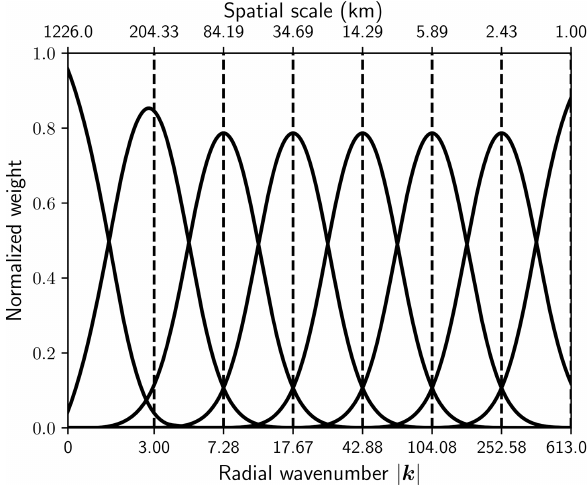
Figure 1. Normalized weight functions with corresponding Fourier wavenumbers and spatial scales for the FMI domain. The domain is a 760 × 1226 grid at 1km